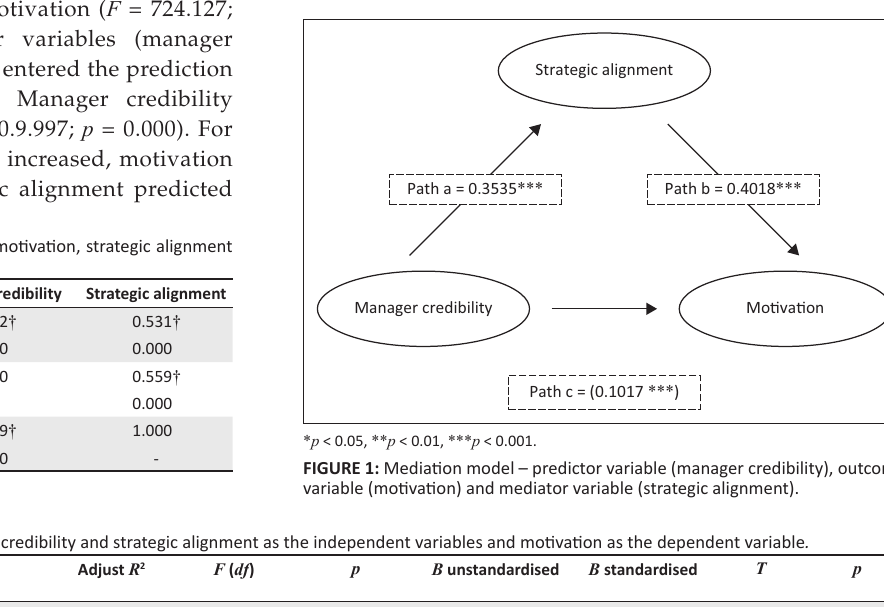
Strategic alignment